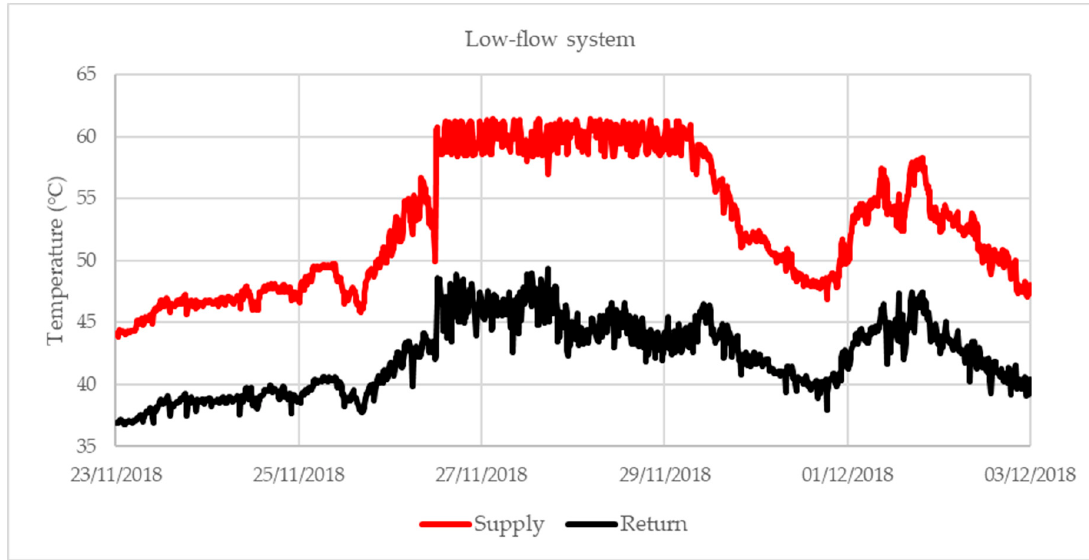
Figure 16. Results of the first strategy based on the low-flow system operation tested on 26 November 2018 in the actual radiator system of the building case study in Viborg. The two curves represent the supply and the return temperature of the radiator system.